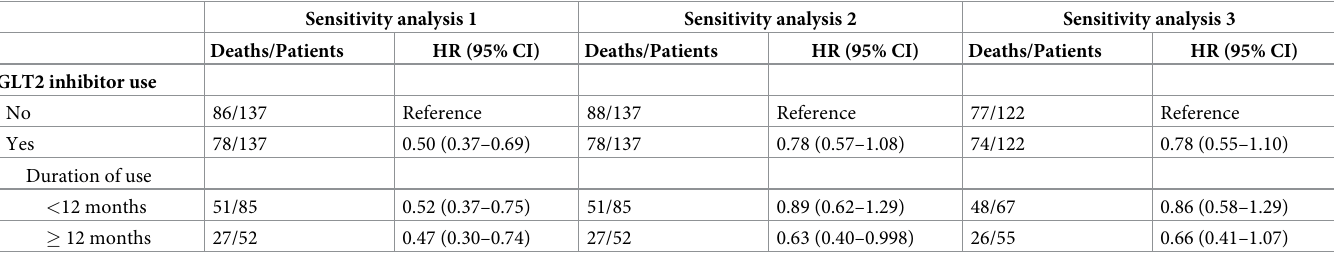
Table 3. Associations between sodium-glucose cotransporter 2 (SGLT2) inhibitor use and mortality among hepatocellular carcinoma patients with T2DM �